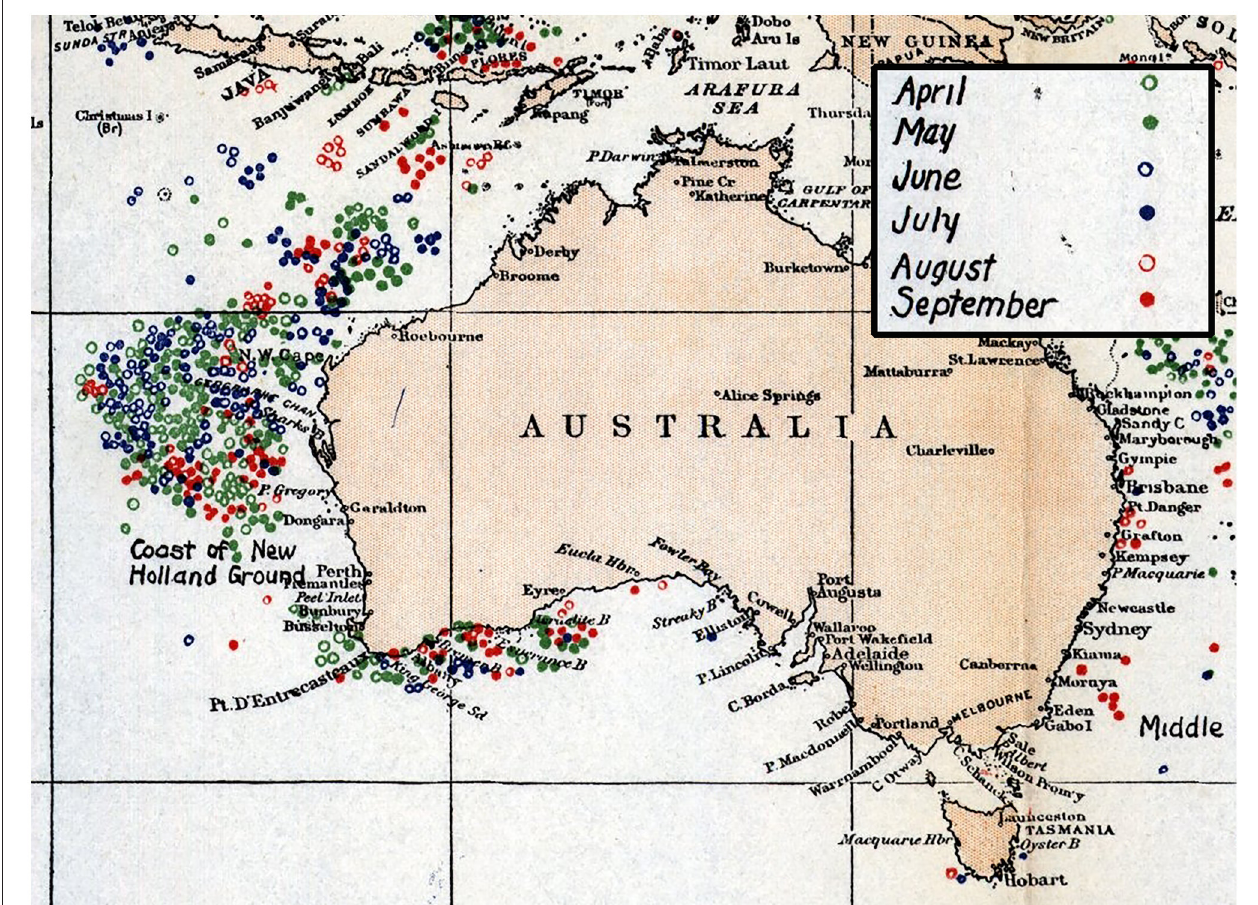
FIGURE 1 | Charts compiled by Charles Townsend details sperm whale kills off Western Australia during Yankee whaling period in months of April–September 1761–1920 (Townsend,